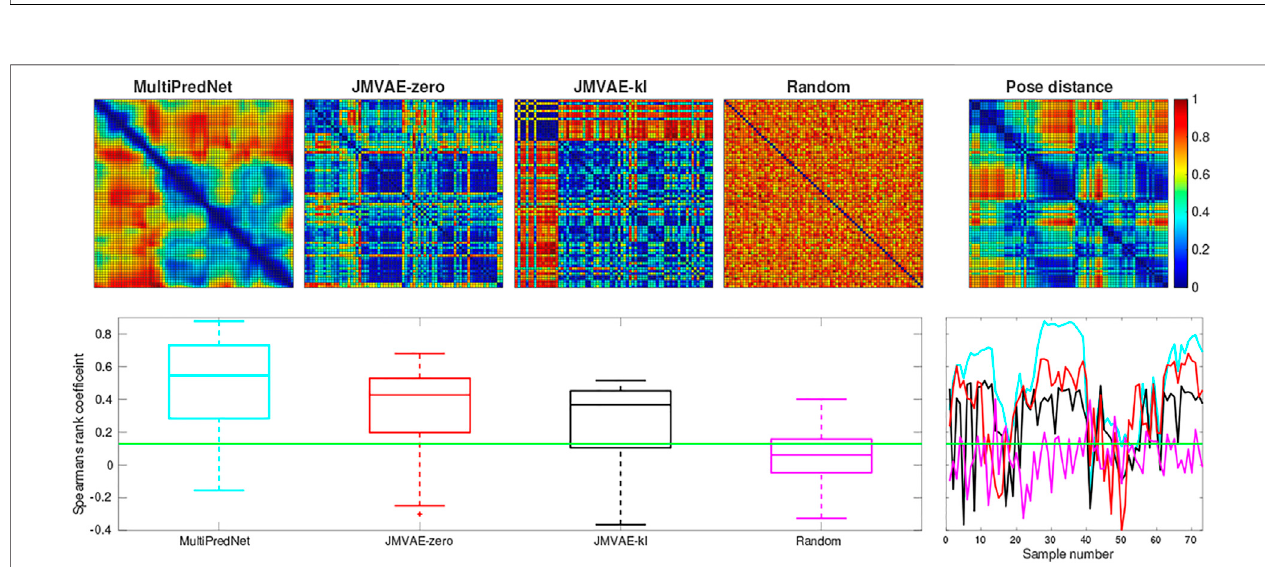
FIGURE5| RepresentationalSimilarityAnalysisofthreetrainednetworkmodelstomeasureperformanceatplacerecognitionacrossasmallexampletestset.The top row presents the Representational Dissimilarity Matrix (RDM) generated from (left to right) MultiPredNet, JMVAE-zero, JMVAE-kl and random representations in responsetovisualandtactilesamplestakenfromphysicaltestset1(73samples).TheRDMonthefarrightwasgeneratedfromtheassociatedgroundtruth3Dposesof WhiskEye ’ s head ( x , y , θ head ) for each sample in the test set. The boxplots in the lower panel summarise statistics of the Spearman ’ s rank correlation coef fi cient ( ρ ) calculated between the pose and representation distances across the test set for each model as shown in the coloured line plots in the panel to the right (cyan: MultiPredNet, red: JMVAE-zero, black: JMAVE-kl, and magenta: Random). The Green horizontal line indicating 99% signi fi cance above chance ( p < 0.001, N (cid:1) 73).